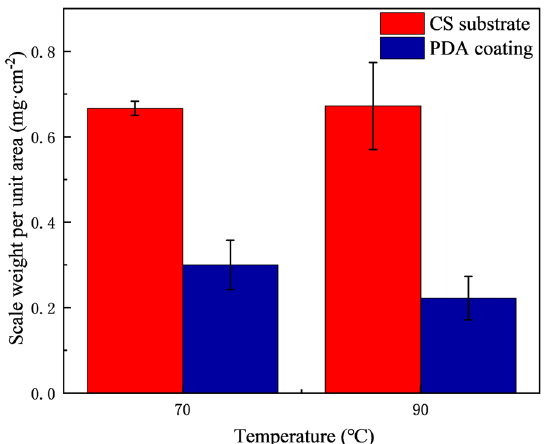
Figure 7. Comparison of CaCO 3 scale deposition on carbon steel (CS) and PDA coating surface.